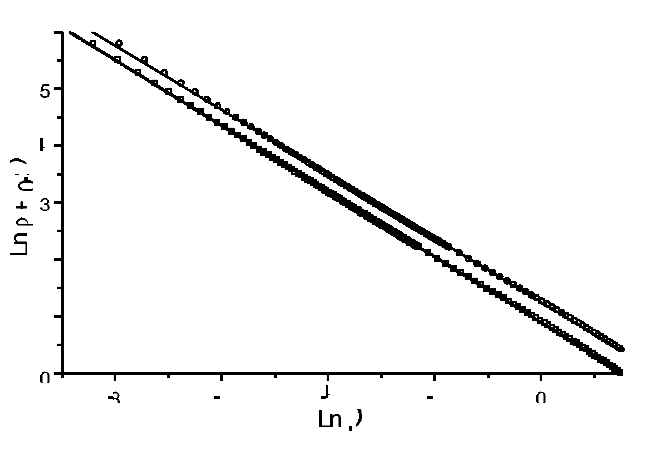
Fig. 2 The Flory-Rhener approximation. 1 { À = 0 : 314 (benzene), 2 { À = 0 : 510 (heptane). The points are the calculated values; the straight lines are the linear ›